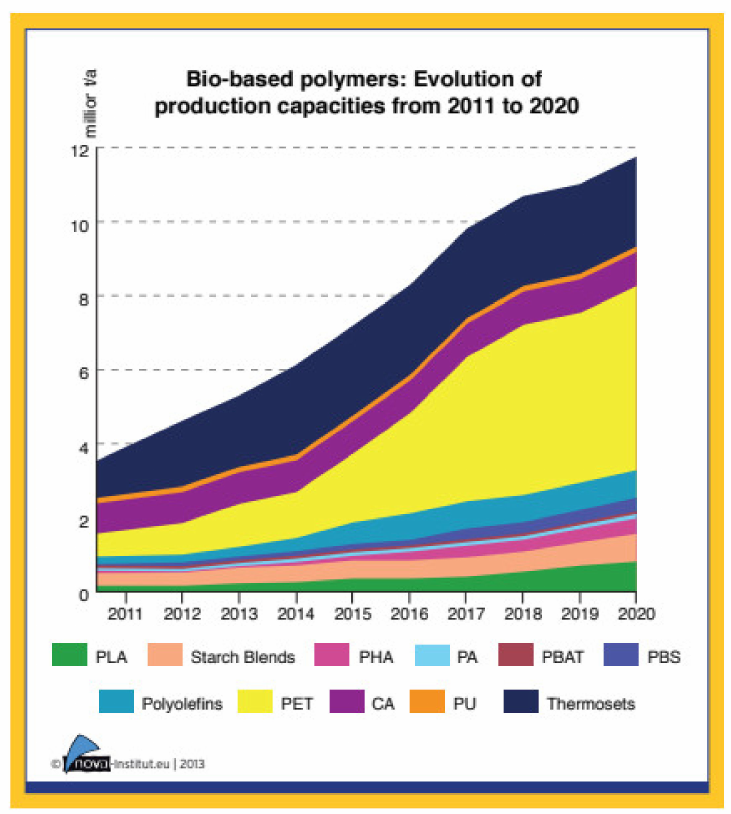
Figure 1. Bio-based polymers production capacities from 2011 to 2020 [14]. PLA: polylactic acid; PHA: polyhydroxyalkanoate; PA: polyamide; PBAT: poly(butylene-adipate-co-terephthalate); PBS: poly(butylene succinate); PET: polyethylene terephthalate; CA: Cellulose acetate; PU: polyurethane. Adapted with permission from Aeschelmann and Carus